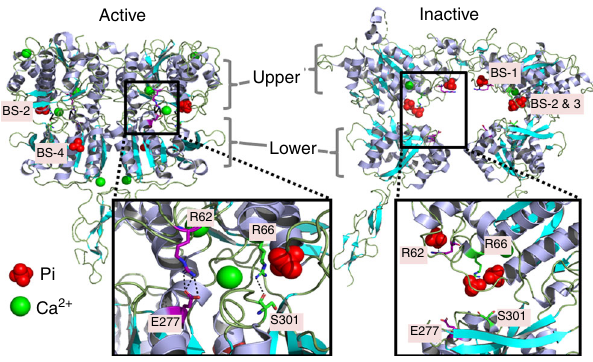
Fig. 5 Pi - binding sites in the CaSR extracellular domain. Pi-binding sites in the CaSR ’ s active and inactive conformations. In the active conformation (left), R62 and R66 interact respectively with E277 (creating a salt bridge) and S302 (hydrogen bond) to keep the upper and lower domain closely associated ensuring a closed/active conformation. In the inactive conformation (right), both interactions are broken and Pi ions stabilize the positive charges of R62 and R66. Also, Pi ions displace a lower domain eliciting an open/inactive conformation, by reducing equilibrium free energy. Note that Pi-binding site 1 is only occupied in the inactive state, whereas Pi-binding site 2 is occupied in both inactive and active conformations integrated within the receptor ’ s structure. Pink sticks show the R62 – E277 salt bridge interaction and green sticks show the R66 – S301 hydrogen bond. PDB accession numbers 5k5s and 5k5t 27 . BS binding site